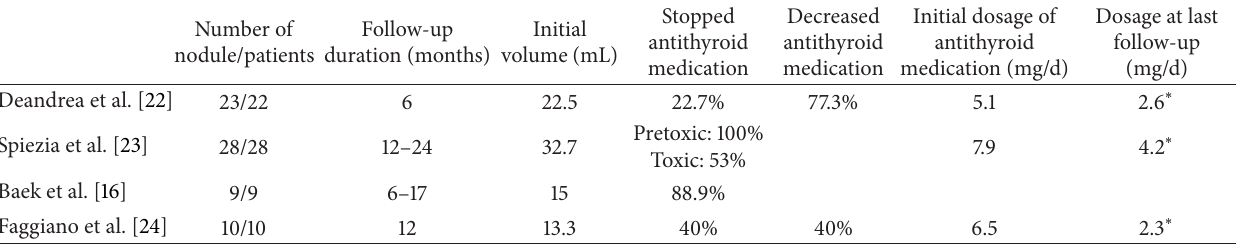
Table 2: Result of patients who underwent radiofrequency ablation for hyperfunctioning thyroid